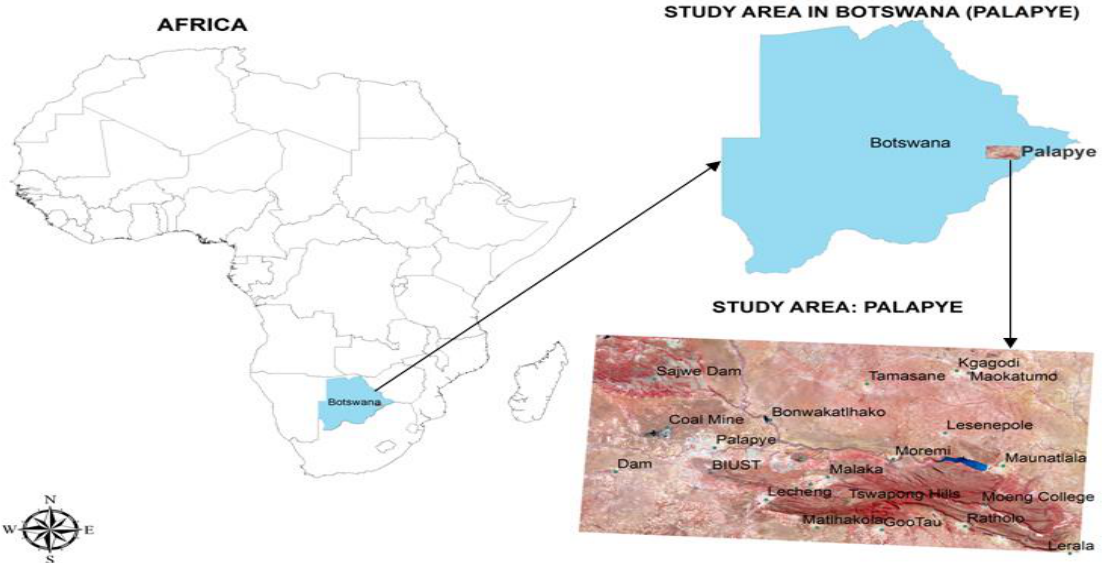
Figure 1: Location of the study area, semi-arid Palapye region in Botswana